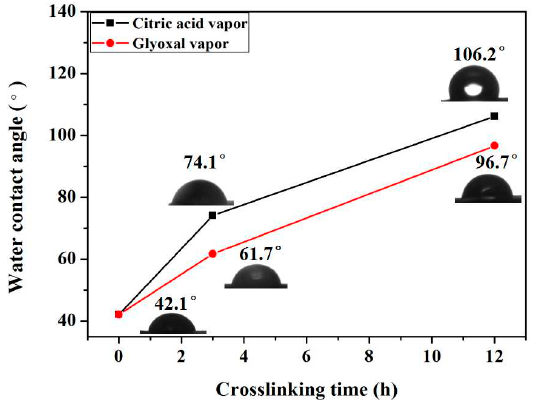
Figure 6. The water contact angle of as-prepared and crosslinked FK/PVA/PEO nanofiber membranes.